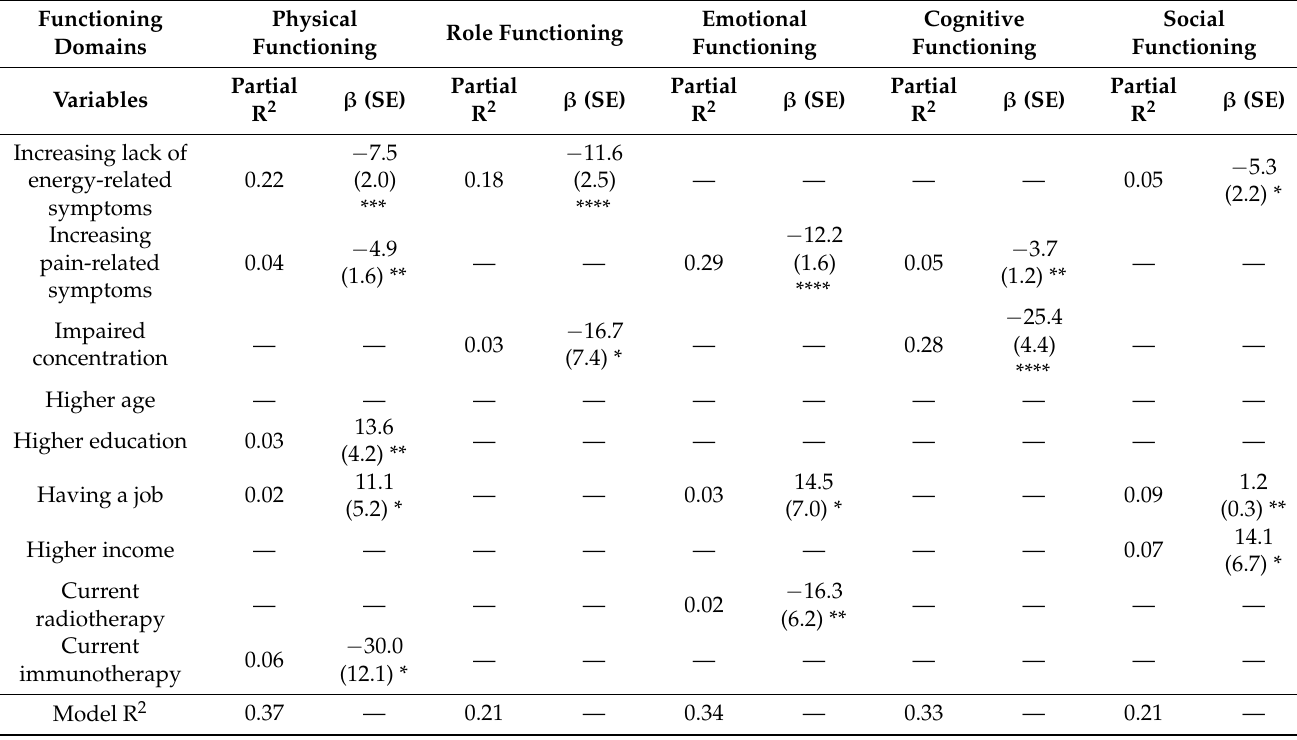
Table 4. Factors affecting functioning in patients undergoing treatment for non-small cell lung cancer (NSCLC).